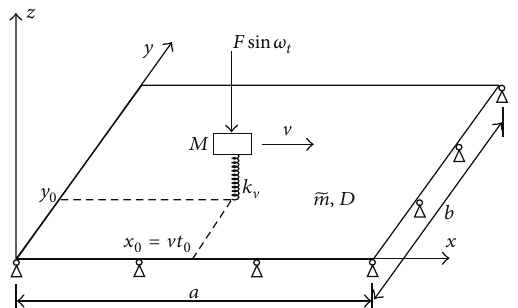
Figure 5: A passing tapping vehicle on a plate, after